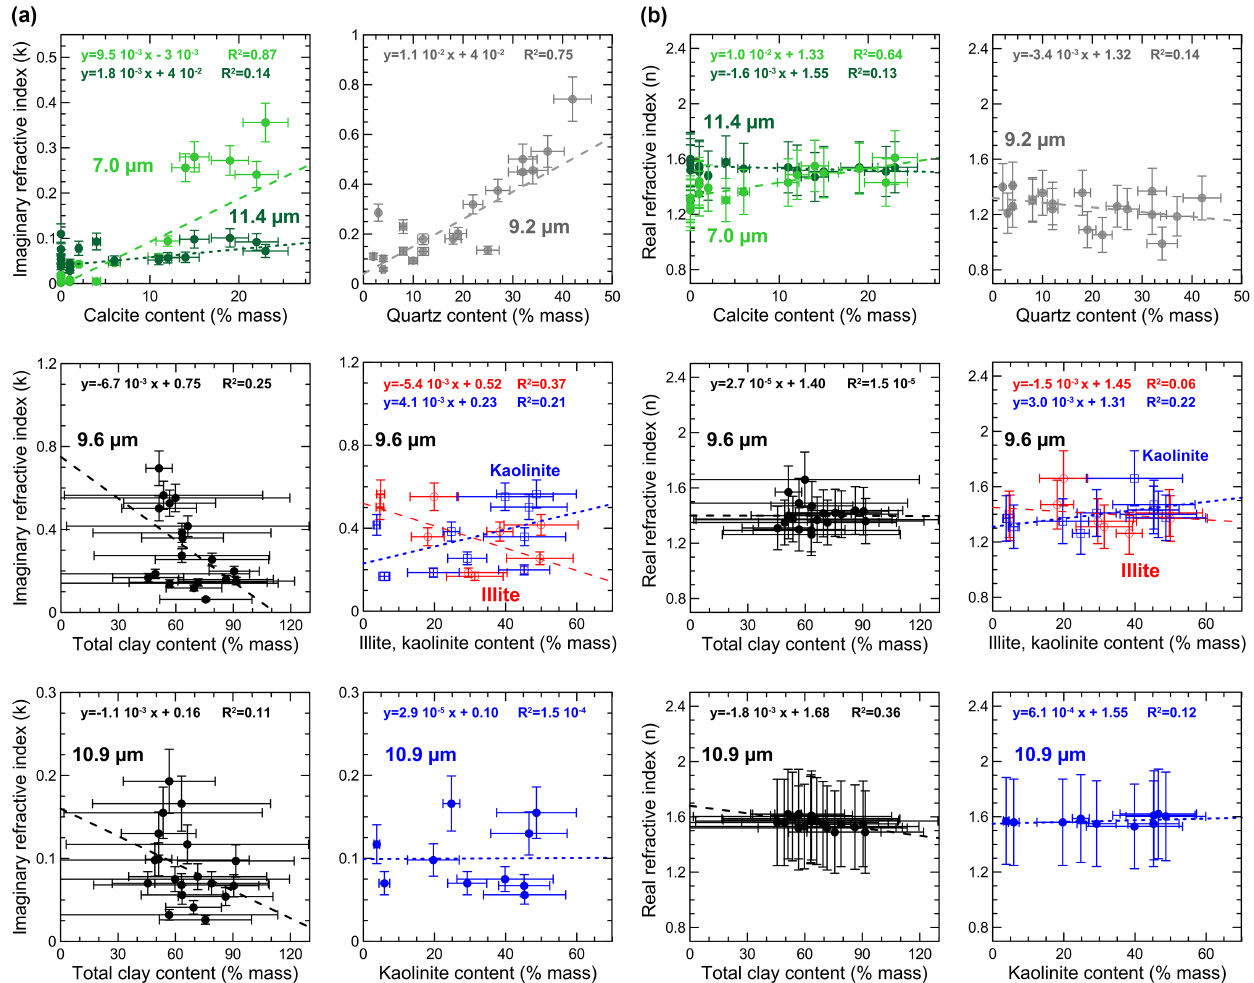
Figure 11. Imaginary part of the complex refractive index ( k ) versus the mineral content (in % mass) for the bands of calcite (7.0 and 11.4µm), quartz (9.2µm), and clays (9.6 and 10.9µm). For the band at 9.6µm the plot is drawn separately for total clays, and illite and kaolinite species. The linear fits are also reported for each plot. Linear fits were performed with the FITEXY.PRO Interactive Data Language (IDL) routine taking into account both x and y uncertainties in the data. Same as Fig. 11a for the real part of the complex refractive index ( n